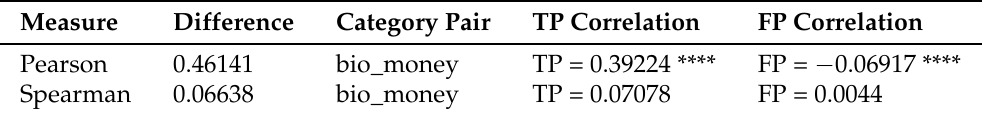
Table 36. Bio and Money in Low.